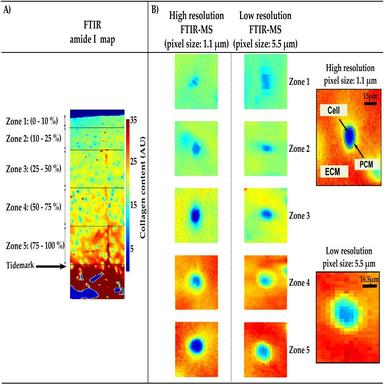
Comparison of high and low-resolution FTIR-MS images across the tissue depth. A) Amide I map of cartilage histological section. B) Representative high-resolution and low-resolution images of chondrocyte microenvironment illustrating that high-resolution FTIR-MS can delineate the cell, estimated PCM and ECM.